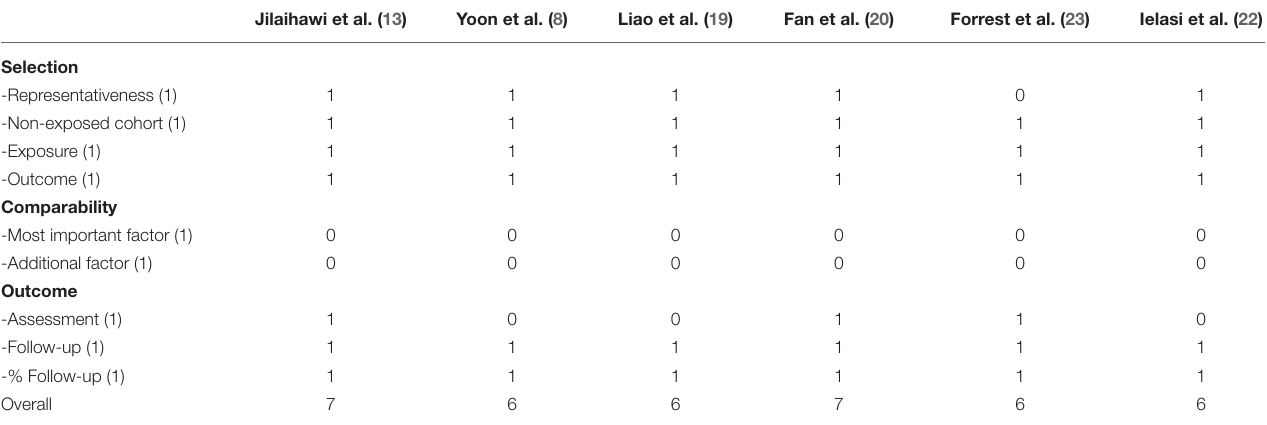
TABLE 1 | The risk of bias of each study by the Newcastle-Ottawa scale criteria. Jilaihawi et al. (13) Yoon et al. (8) Liao et al. (19) Fan et al. (20) Forrest et al. (23) Ielasi et al.